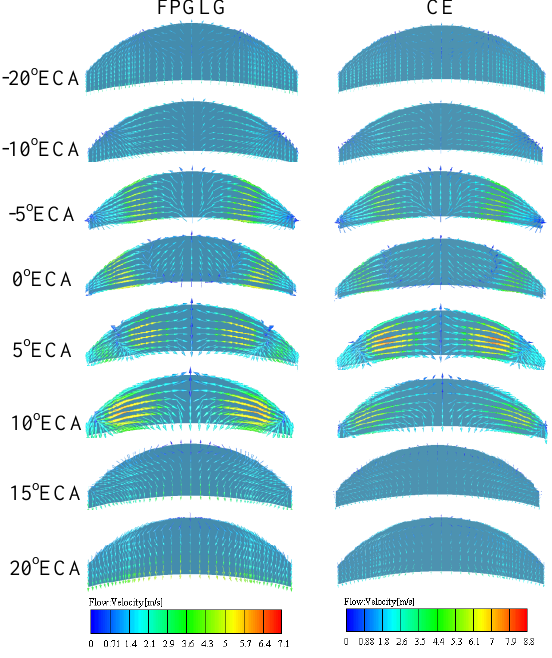
Figure 12. The in-cylinder gas flow field of the FPGLG and the CE.